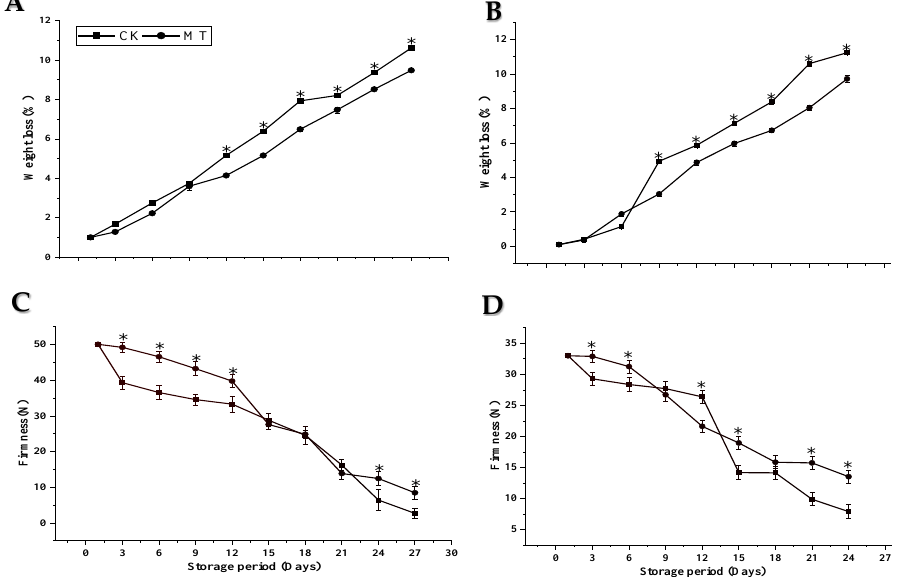
Figure 1. Weight loss ( A , B ) and firmness ( C , D ) of ‘Guiqi’ ( A , C ) and ‘Tainong 1′ ( B , D ) fruits treated with 1000 μmol L −1 MT stored at 13 ± 1 °C and 80 ± 1% RH. Each value is the mean for three replicates, and vertical bars indicate the standard error (SE). Error bars with an asterisk (*) on the same storage period show a significant difference between the treatments ( p < 0.05).